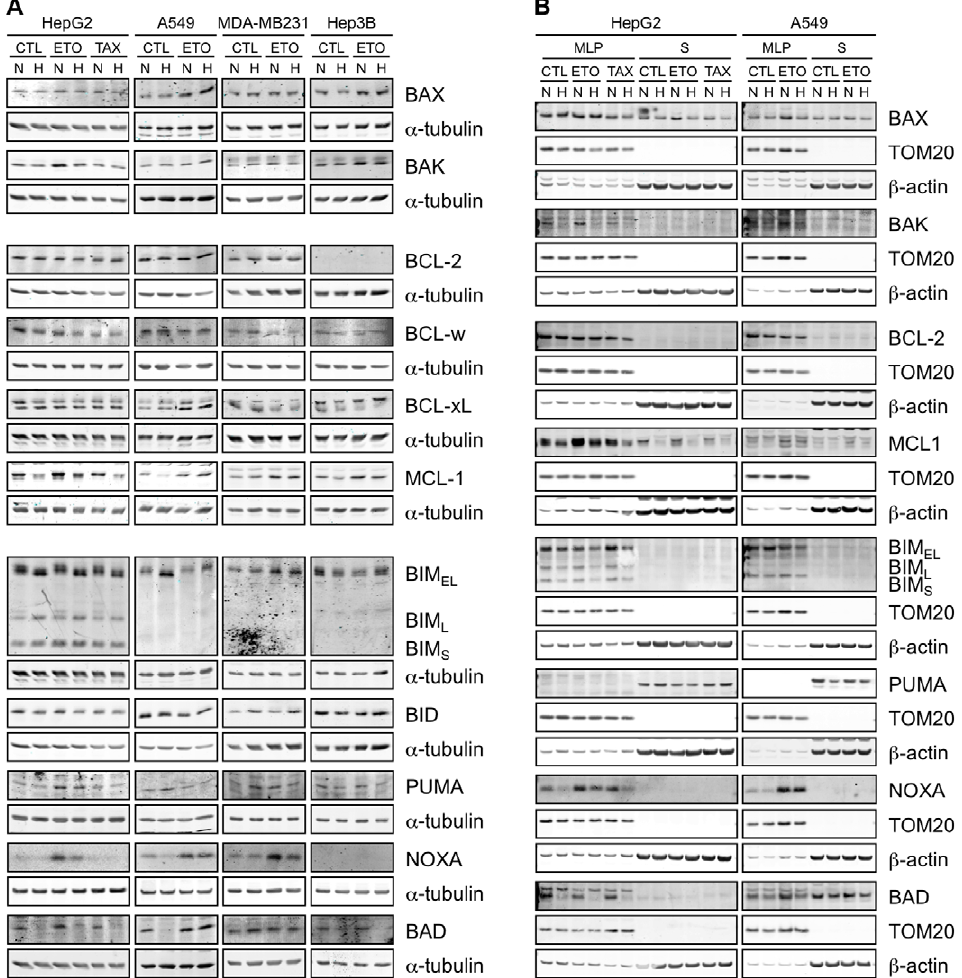
Figure 6. Effect of hypoxia, etoposide and paclitaxel on the abundance and localisation of BCL-2 family proteins. HepG2, A549, MDA- MB231 and Hep3B cells were incubated 16 hours under normoxia (N, 21% O 2 ) or hypoxia (H, 1% O 2 ) in the presence or not (CTL) of etoposide (ETO, 100 m M in Hep3B cells and 50 m M in the other cell types) or paclitaxel (TAX, 10 m M) in HepG2 cells. (A) Proteins were detected in total cell extracts by western blotting, using specific antibodies. alpha-tubulin was used as loading control. One experiment representative out of three. Uncropped western blots are presented in Figure S1. (B) After the incubation, subcellular fractionation was performed and proteins were detected in the MLP (mitochondria-lysosome-peroxisome) and S (cytosolic) fractions by western blotting, using specific antibodies. TOM20 and b -actin were used as loading controls for the MLP and S fractions respectively. One experiment representative out of three. Uncropped western blots are presented in Figure S1.